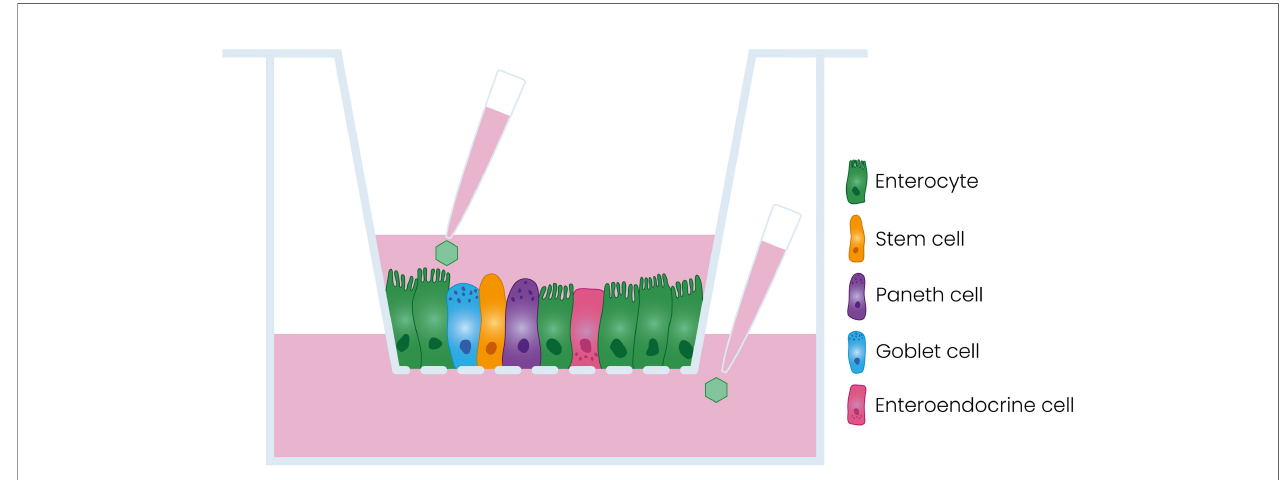
FIGURE 1 | Schematic representation of the model used in this study. Dissociated enteroids are seeded on a porous Transwell ® insert where they form a polarized monolayer containing the different cell types of the intestinal